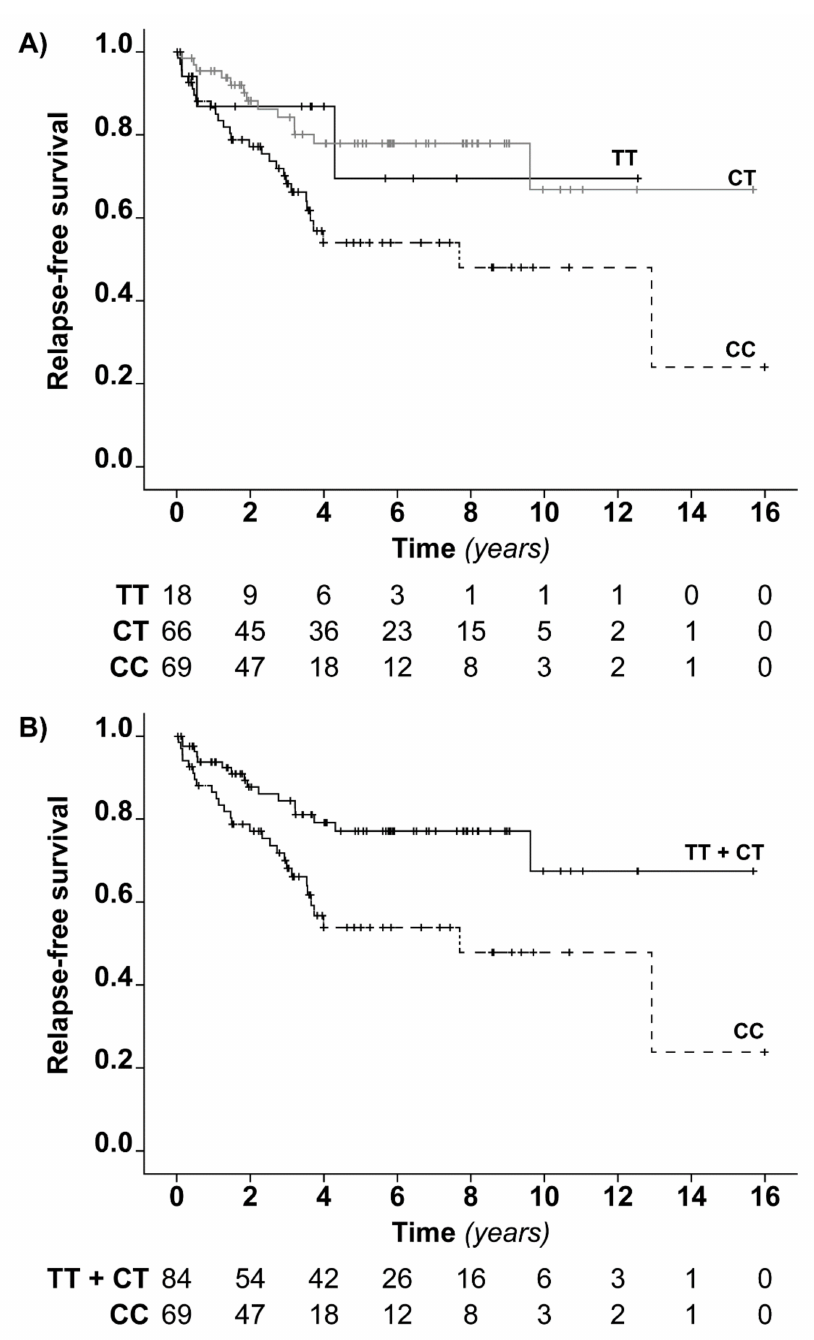
Figure 2. Relapse-free survival analysis in iTTP patients according to the rs6903608 genotype. ( A ) The Kaplan–Meier curves show the cumulative probability of being relapse-free in iTTP patients homozygous for the risk allele (CC), heterozygous (CT) and homozygous for the reference allele (TT). ( B ) Kaplan–Meier curves show the cumulative probability of being relapse-free in iTTP patients homozygous for the risk allele (CC) and carriers of reference allele (TT + CT). Tick-marks indicate censored subjects. Below the figures, the numbers of subjects at risk of TTP relapse at 0, 2, 4, 6, 8, 10, 12, 14 and 16 years from the remission of the first acute episode are